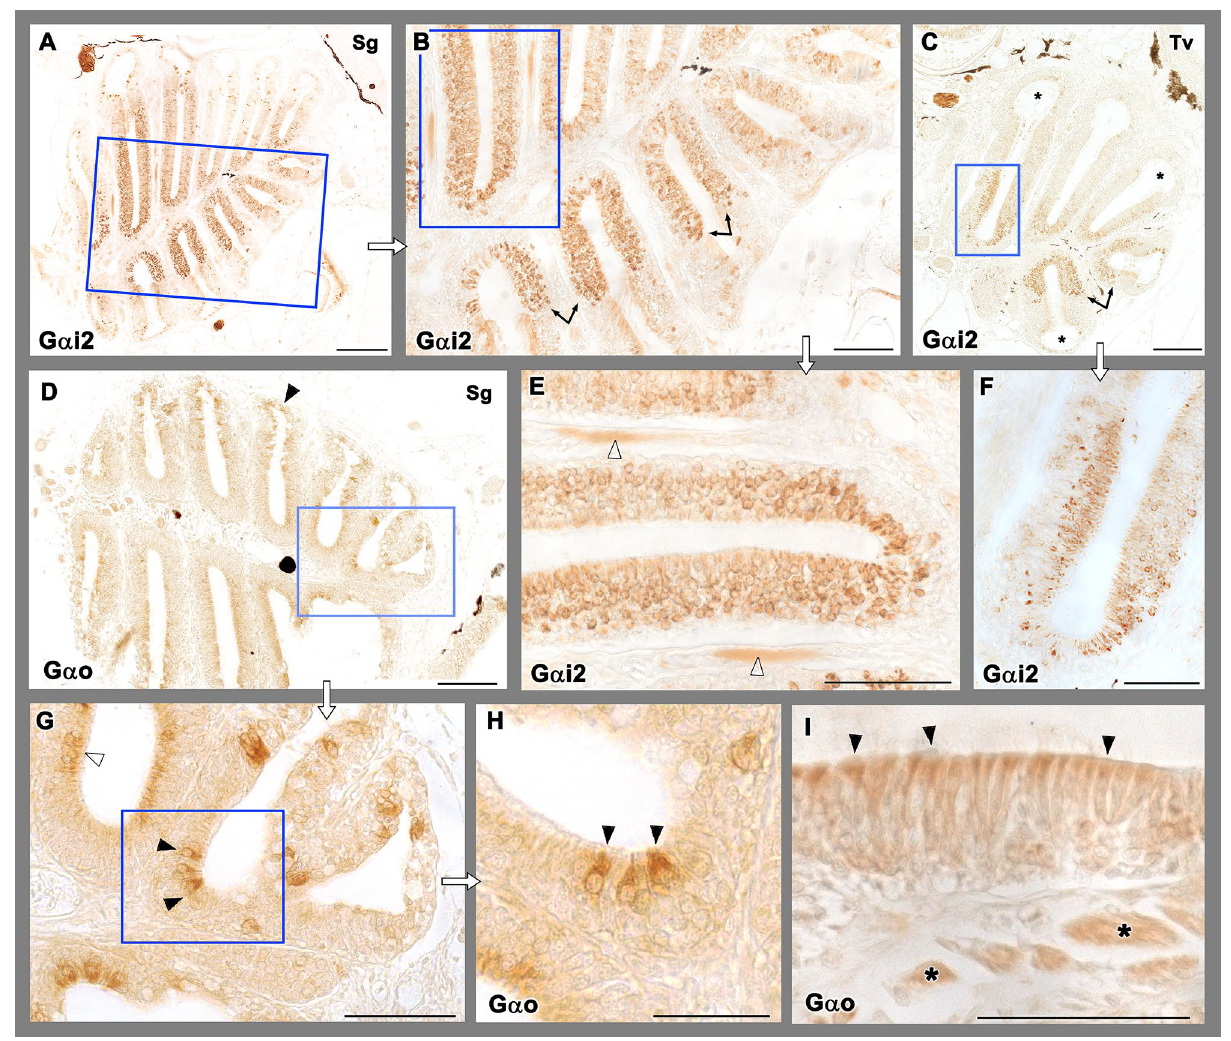
Figure 3. Immunohistochemical study of the olfactory rosette of zebrafish with antibodies against G-proteins. ( A – C , E , F ) Anti-Gαi2 immunolabelling. ( A ) Sagittal sections show a higher number of immunopositive neurons in the internal parts of the rosette, at both sides of the median raphe. ( B ) Higher magnification of the inset in ( A ). The transition between both the nonsensory and sensory epithelium is straight (arrows). ( C ) Transverse sections show how the lateral rim of the lamella (asterisks) lacks of anti-Gαi2 immunolabelling. ( E ) Inset in ( B ) showing the immunopositive olfactory nerves (white arrowheads). ( F ) Inset in C shows how the basal part of the neuroepithelium lacks immunopositive cells. ( D , G – I ) Anti-Gαo immunolabelling. ( D ) The immunoreactivity was present diffusely in apical neurons, as it is shown by open arrowheads in the inset ( G ). Additionally, more isolated big and oval receptor neurons showed immunoreactivity (black arrowheads) ( H , inset in G ). ( I ) The processes in the nonsensory epithelium (arrowheads) and the branches of the olfactory nerves (asterisks) are also immunopositive. Scale bar: 100 μm ( A , C , D ); 50 μm ( B , E – I